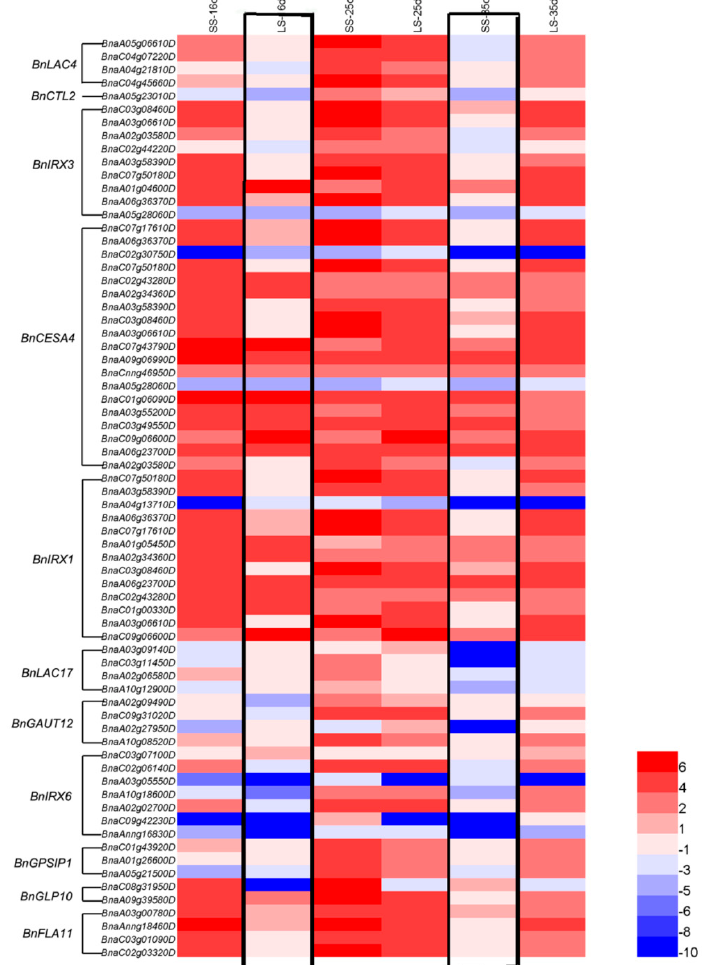
Figure 12. RNA-seq of BnLAC4 BnCTL2, BnIRX3, BnCESA4, BnIRX1, BnLAC17, BnGAUT12, BnIRX6, BnPGSIP1, BnGLP10 and BnFLA11 genes in six kinds of B. napus silique pericarps. LS, long silique lines; SS, short silique lines. The 16, 25, and 35 d means DAF. The bar on the lower right corner represents the FPKM values and different colors represent different expression levels. Heat map was generated by HemI 1.0 software (http://hemi.biocuckoo.org/faq.php). Lower expression between long and short silique lines at 16th and 35th DAF were indicated by black box.